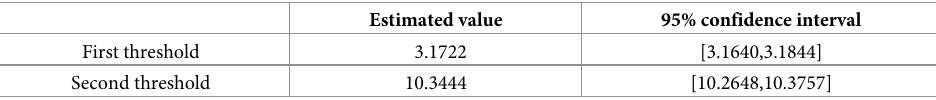
Table 6. Threshold estimates and confidence intervals.